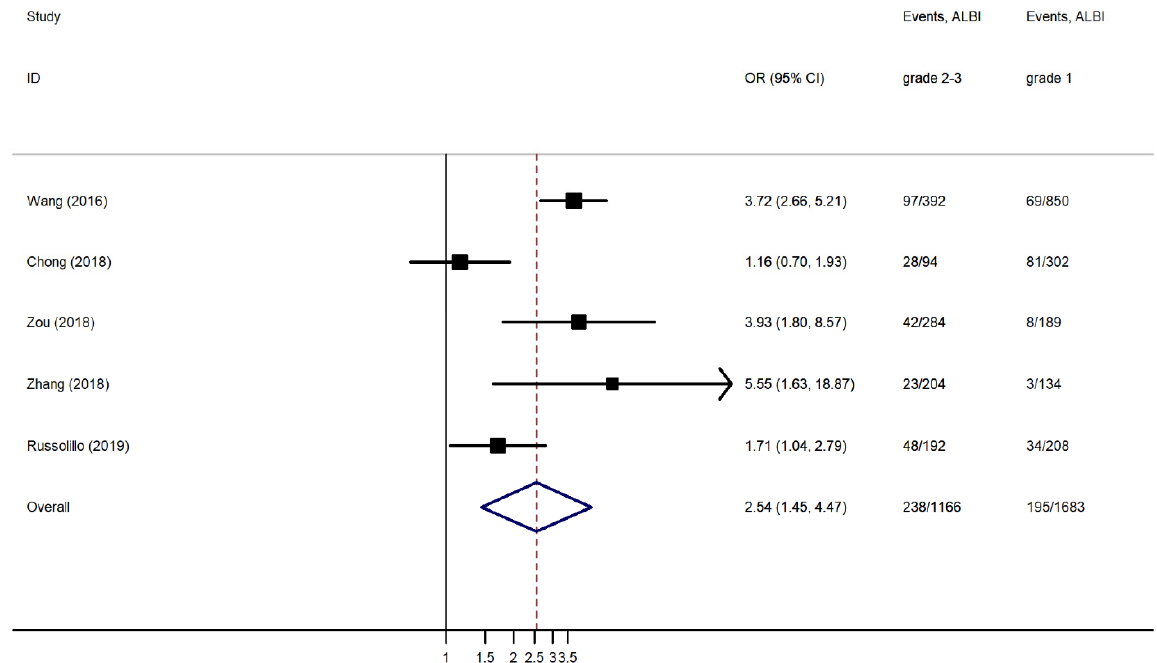
Figure 5. Forest plot of the pooled Odds Ratio (OR) for post-hepatectomy liver failure (PHLF) in ALBI grades 2 and 3 compared to ALBI grade 1 after removing two studies that included only PHLF B and C as case groups. Events: PHLF/No PHLF; and CI: Confidence Interval.